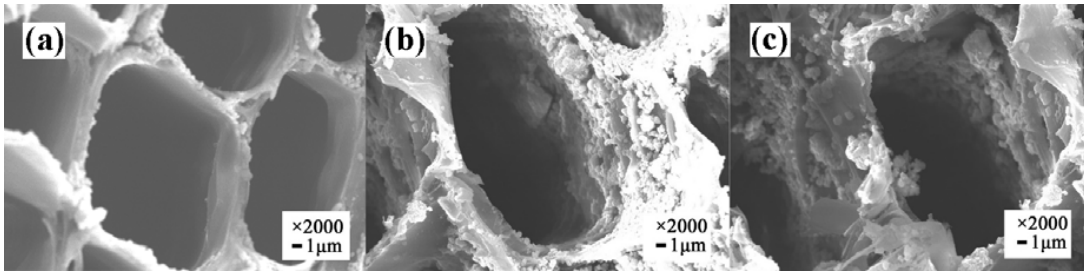
Figure 2. Field emission scanning electron microscopy (FESEM) of ( a ) original wood, ( b ) UW, and ( c ) VW.